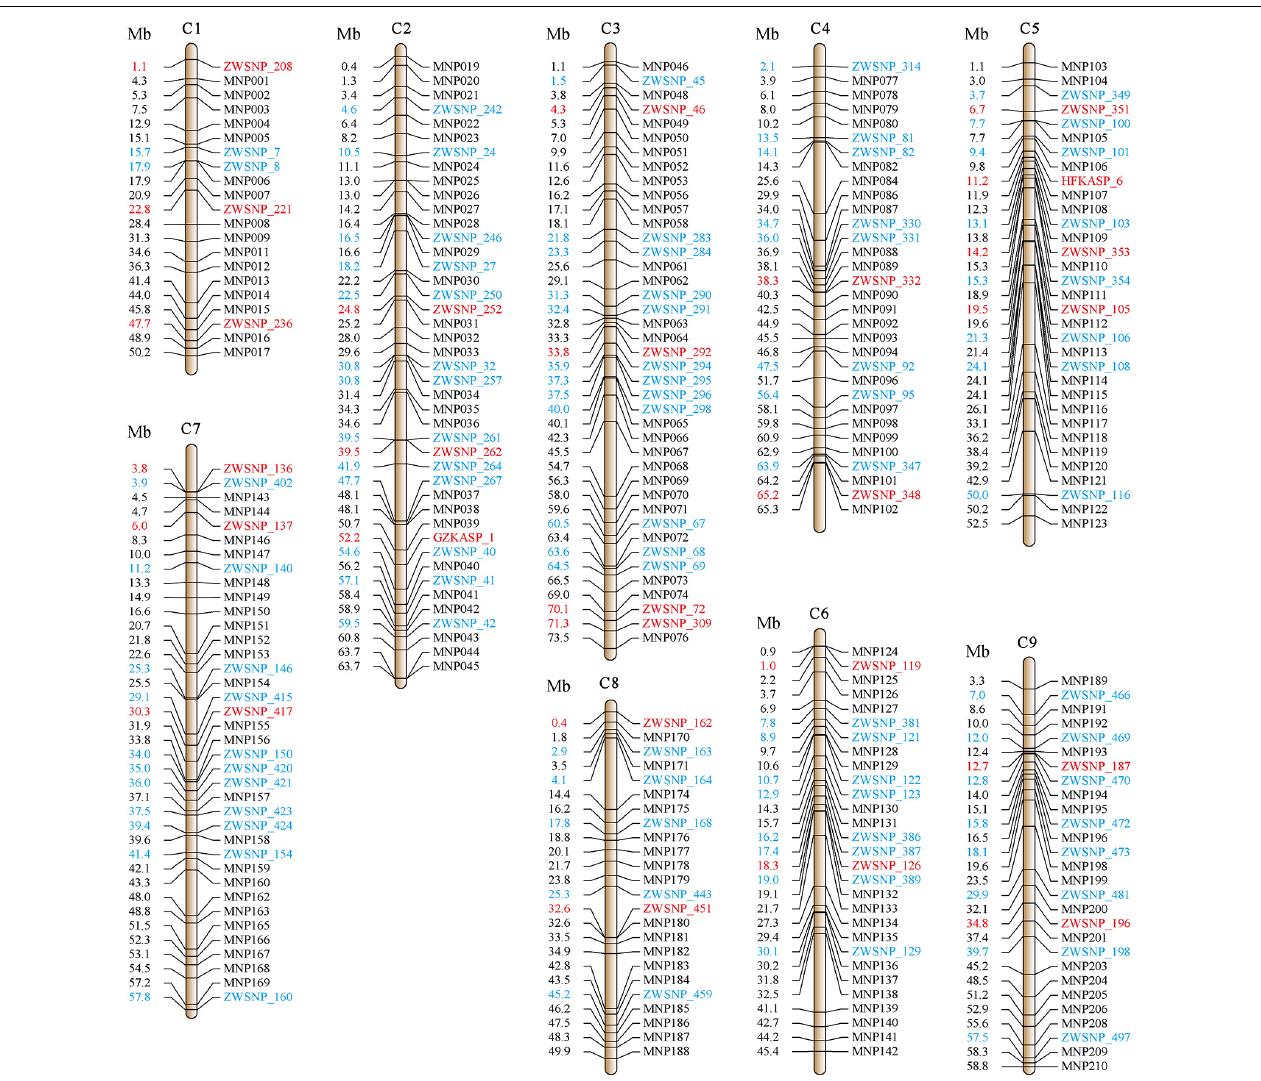
FIGURE 2 | Distribution of all markers among broccoli chromosomes. The horizontal lines perpendicular to a chromosome represent the markers developed in this study, among which the black ones were developed by the GBTS panel, the blue and red ones were developed by the KASP panel, and the red ones were core KASP markers selected for fingerprinting of broccoli